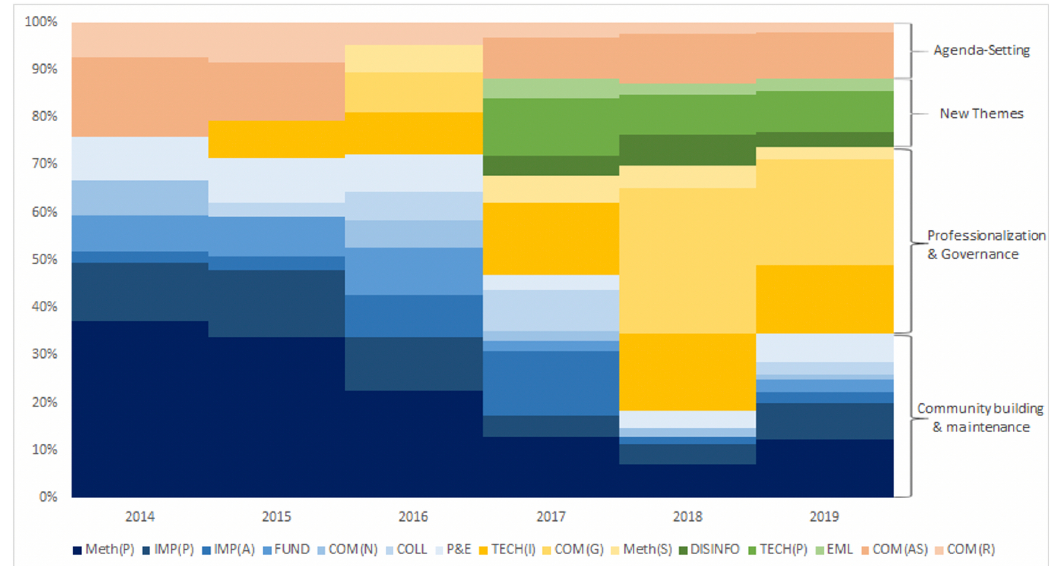
Figure 1. Major thematic clusters across six Global fact conferences (% event